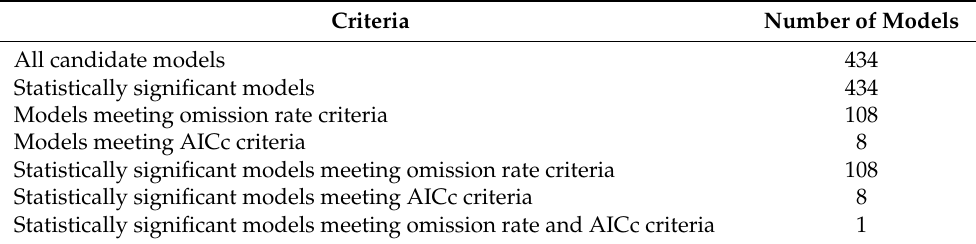
Table 6. General statistics of models that met distinct criteria.